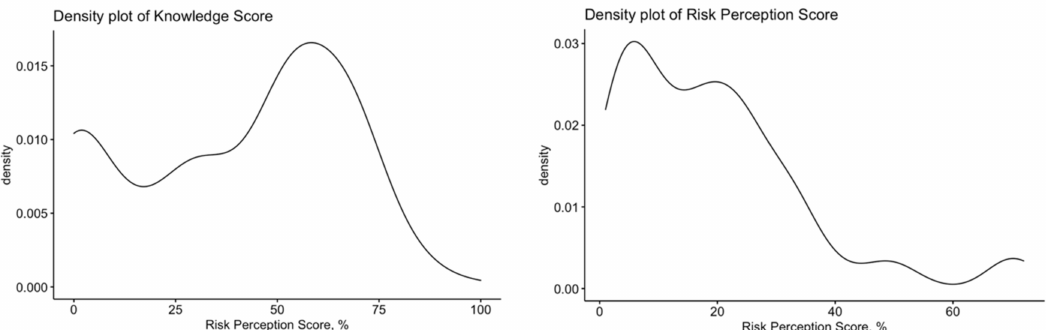
Figure 1. Left to right, density plot for knowledge score, and risk perception score in 223 Italian physicians participating into the survey. Cumulative scores were neither skewed (D’Agostino–Pearson’s normality test p value < 0.001 for both scores) nor significantly correlated in Spearman’s ranks correlation test (R = 0.087; p =